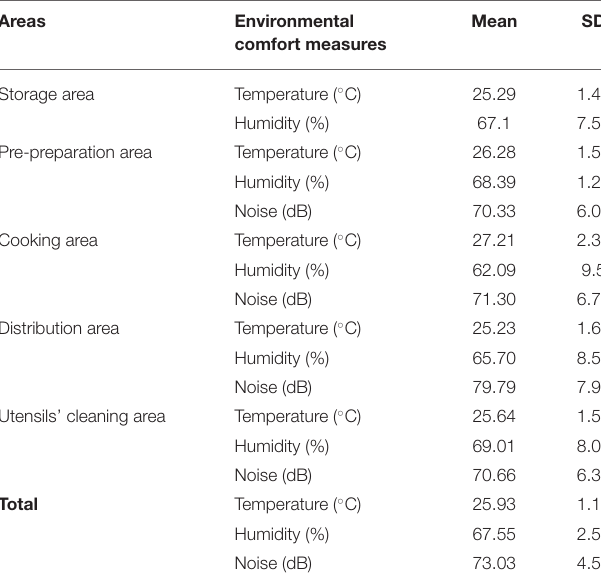
TABLE 2 | Mean and standard deviation of environmental comfort measures in the areas of the SFS (Bahia/Brazil). Areas